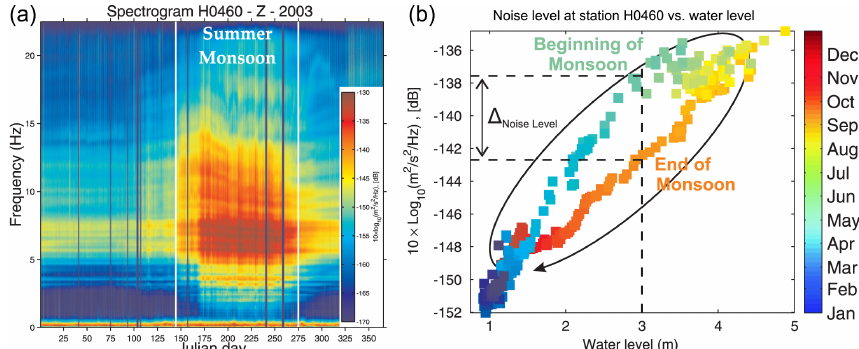
Figure 5. (a) Time–frequency analysis of the vertical seismic signal recorded at station H0460 from the Hi-CLIMB experiment in Nepal. Red and blue colours represent high and low level of seismic energy given in decibels relative to the velocity. (b) Daily average seismic energy in the [3–15]Hz frequency band at H0460 (a) as a function of the daily measured water level of the Trisuli River. Each square stands for a day and the colour the time evolution during 2003. After Burtin et al. (2008).